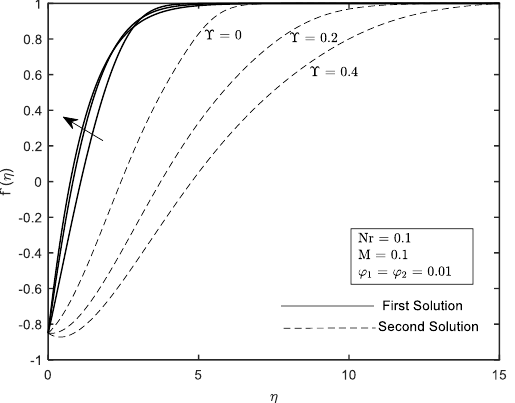
Figure 21. 𝑓 ′ (𝜂) on different ϒ .